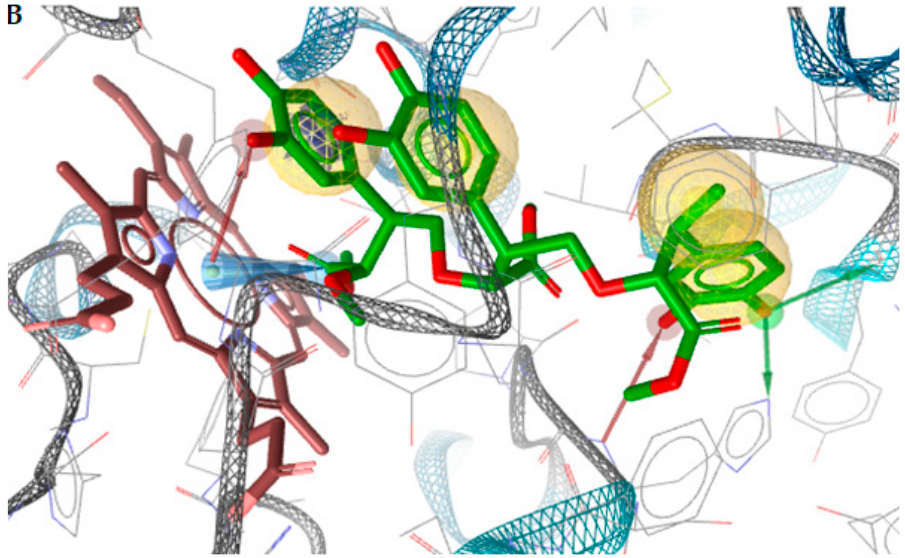
Figure 7. ( A ) A 2D diagram of trimer molecule 2 in CYP51 ca . ( B ) Docked pose of trimer molecule 2 in CYP51 ca . Red and green dotted lines show the hydrogen bonds. Yellow spheres represent hydrophobic interactions, and blue arrows represent aromatic interactions.